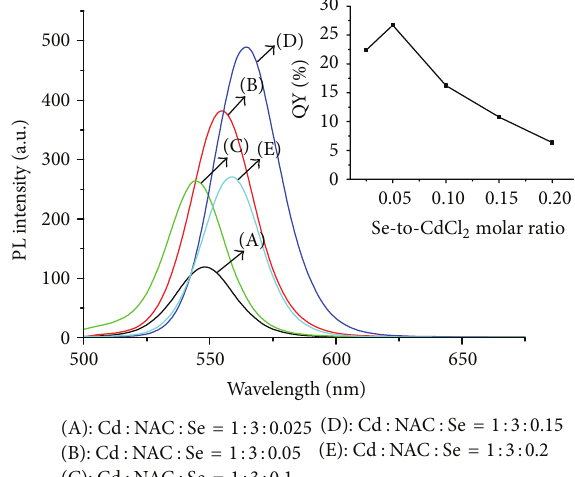
Figure 1: Corrected PL spectra of NAC-capped CdSe QDs prepared at various reaction times; the inset shows the QYs of these prepared QDs. Figure 2: Corrected PL spectra of NAC-capped CdSe QDs grown